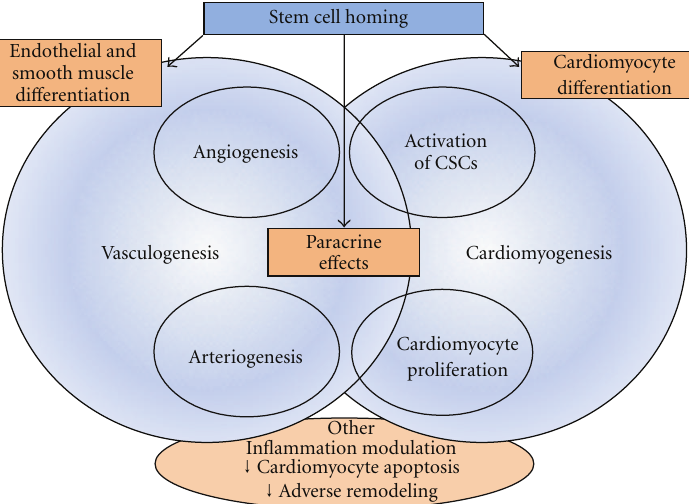
Figure 3: Proposed mechanisms of stem cell function after homing into thedamaged heart. Note thatdi ff erentiation processes and paracrine e ff ects activate a cascade of events that interact actively to create new blood vessels and cardiomyocytes, with the final objective of functional cardiac repair. CSCs: cardiac stem